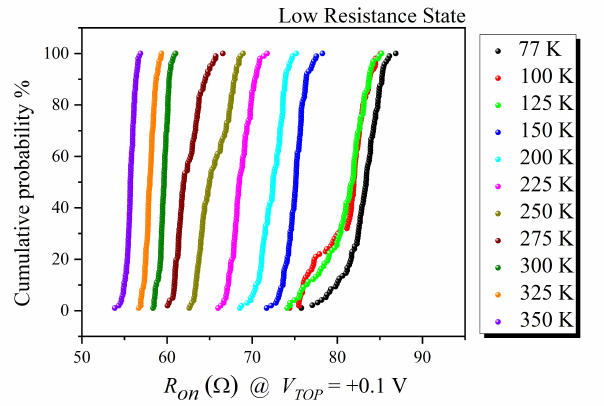
Figure 3. R on @ V TOP = +0.1 V cumulative probability measured at different temperatures ranging from 78 K to 350 K.